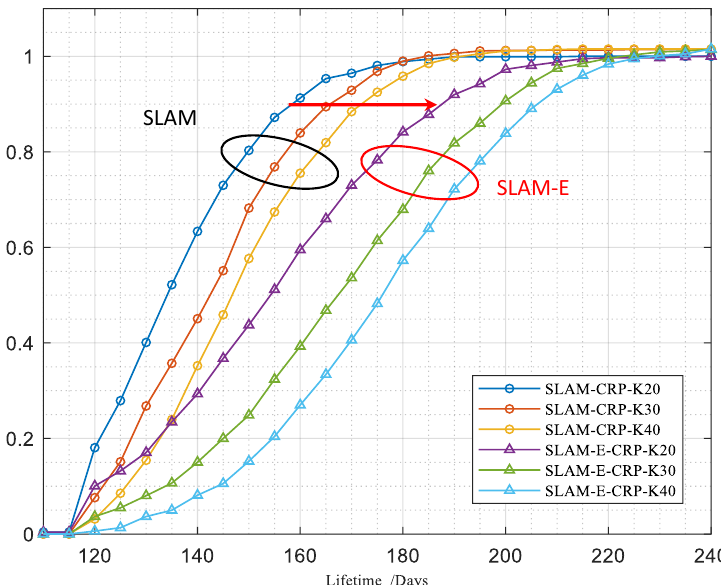
Figure 8. Cumulative distribution of network lifetime ( α = 0.5, a large circle is used to group results of the same method together).